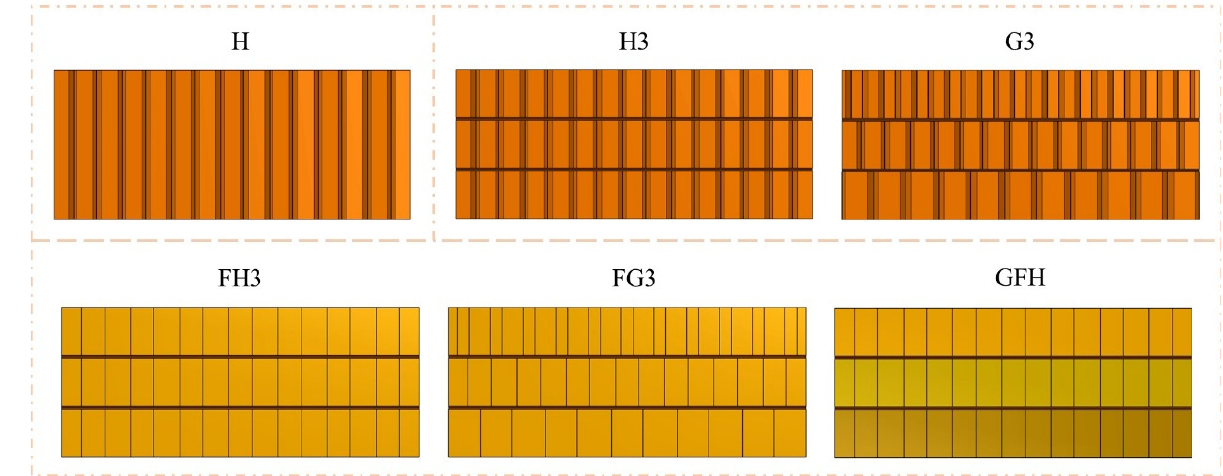
Figure 3. Core types of sandwich panel. Table 3. Types of core structure.